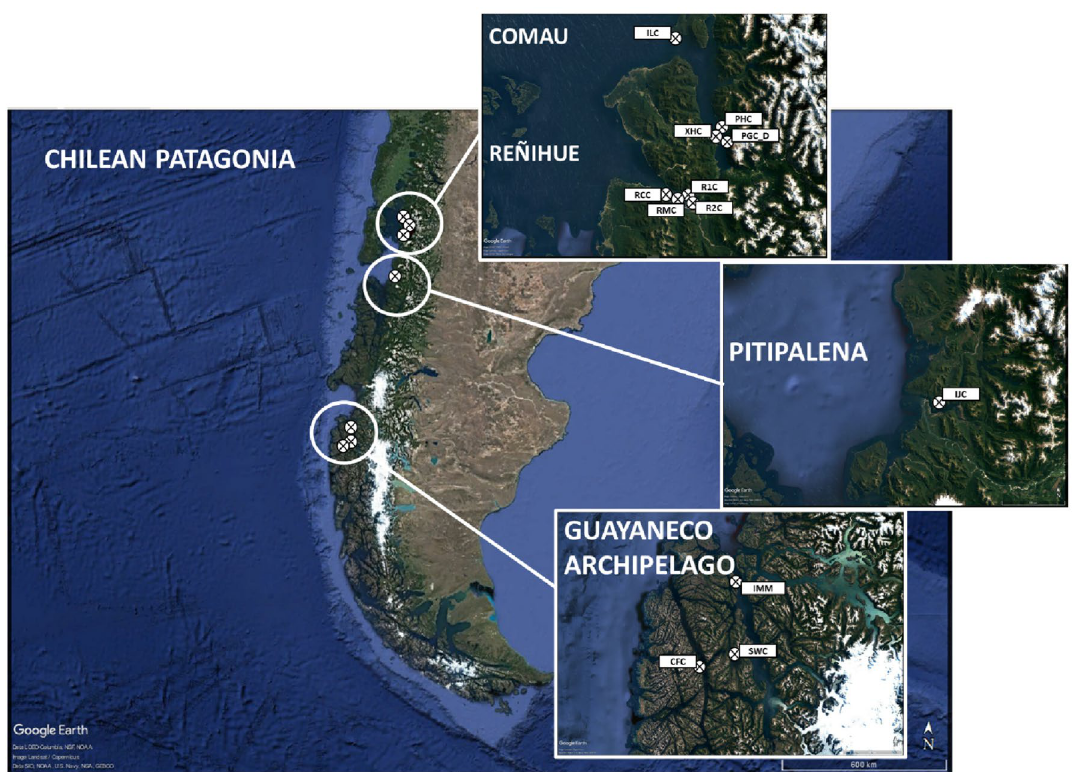
Figure 1. Map of sampling sites (including inserts with detailed locations) in: Comau Fjord [Isla Lilihuapi (ILC), Punta Huinay (PHC), Cross Huinay (XHC), and Punta Gruesa (PGC_D)]; Reñihue Fjord [Dive 1 (R1C), Dive 2 (R2C), Punta Morro Gonzalo (RMC), and Cabudahue (RCC)], Pitipalena Fjord [Isla Jaime (IJC)]; and Guayaneco Archieplago [Isla Millar (IMM), Seno Waldemar (SWC), and Canal Fallos (CFC)]. For complete information of each locality, see Table 1. All maps were created with Google Earth Pro 7.3.4.8642 95 .